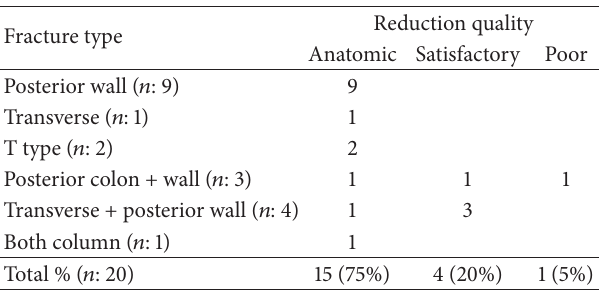
Table 2: Reduction quality according to fracture